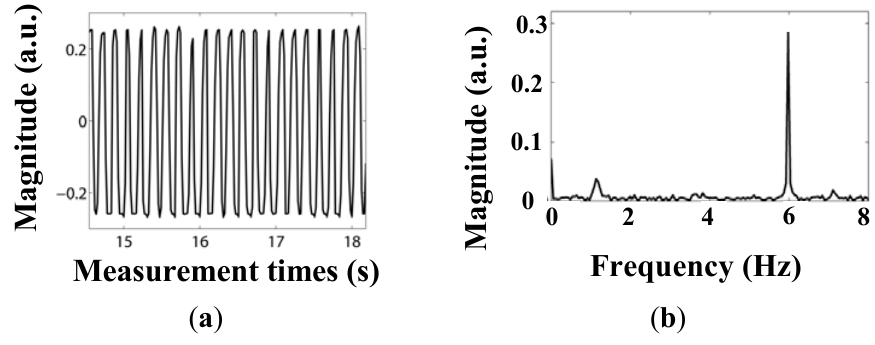
Figure 13. ( a ) Dynamic load experiment results under vibration frequency of 6 Hz; ( b ) Signal frequency analysis under vibration frequency of 6